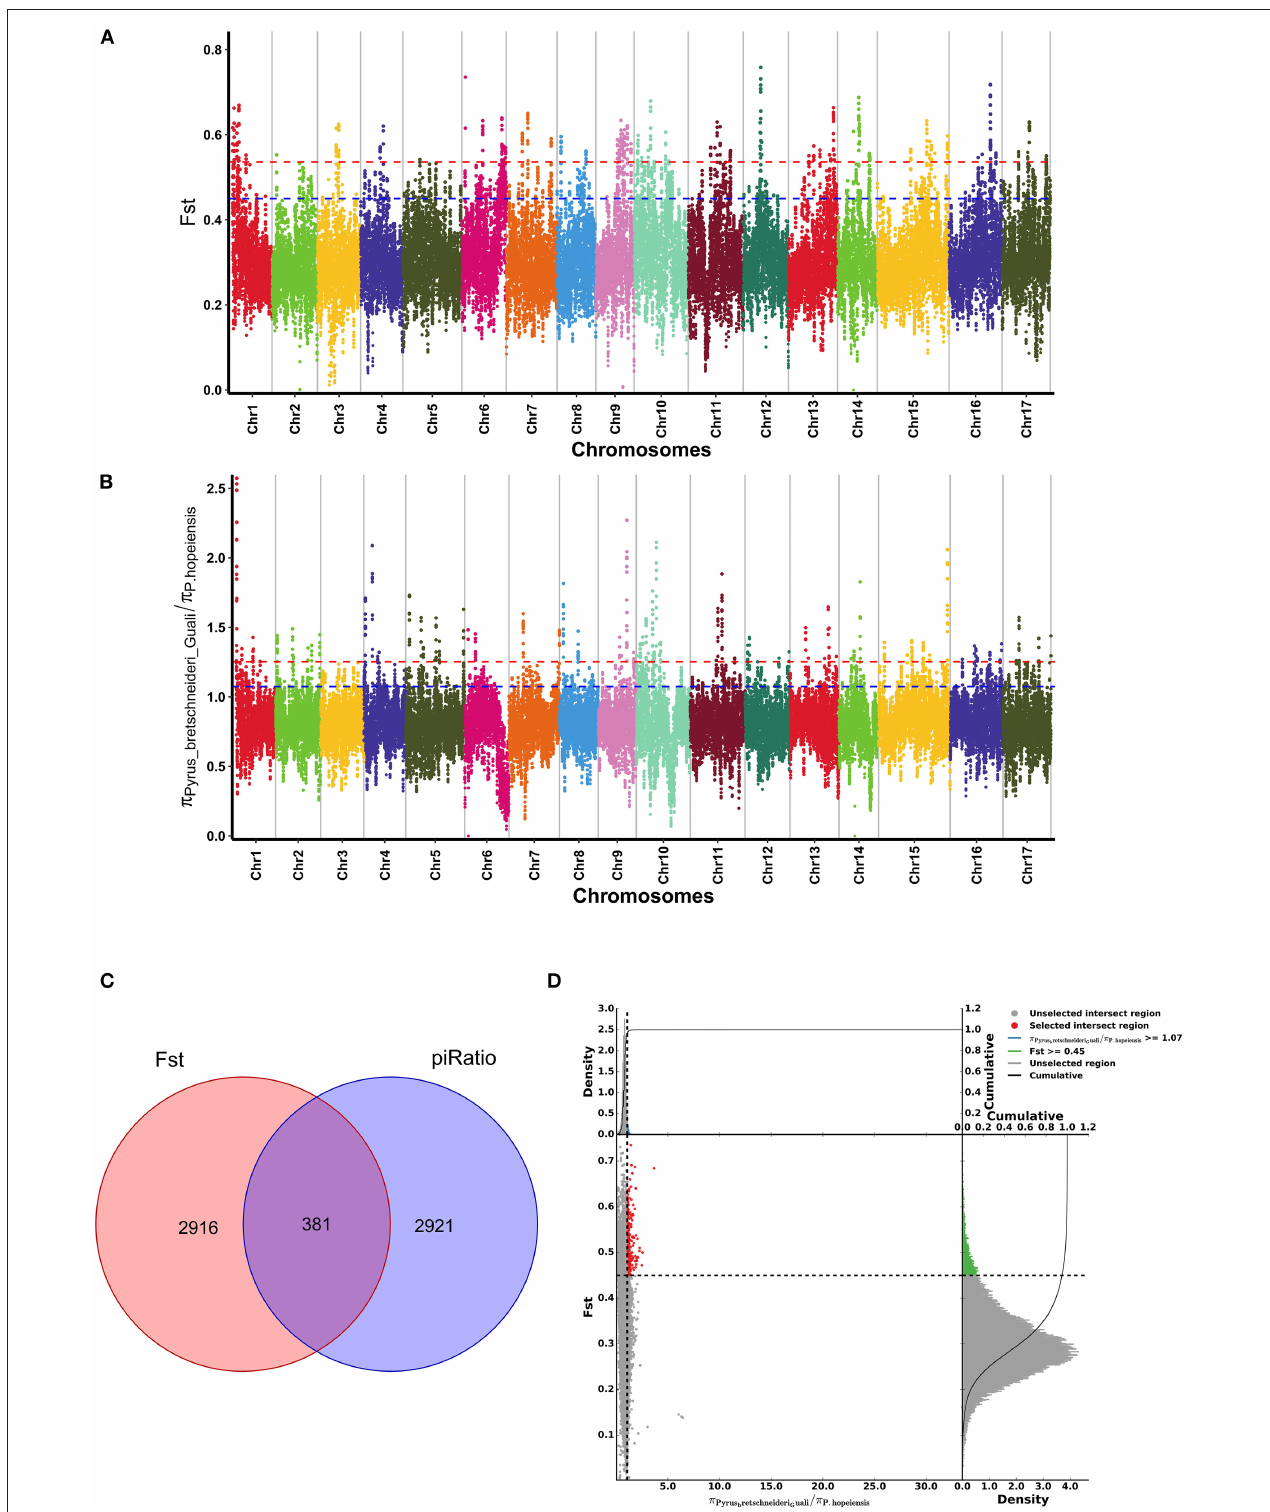
FIGURE 8 | Genome-wide selection scan of Pyrus hopeiensis . (A,B) Manhattan plot of the genome-wide distribution of Fst values and π ratios in P . hopeiensis using a 100-kb window size and a 10-kb step size. (C) Venn diagram showing the gene overlap among Fst values and π ratios in the significant selection region. (D) Selective sweep analysis of P . hopeiensis based on Fst values and π ratios. The transverse coordinates are π ratios and the longitudinal coordinates are Fst values. The dot plot in the center presents the corresponding Fst values and π ratios in different windows. The red region indicates the top 5% of regions selected by π and Fst. The area below the black curve indicates the enriched area.